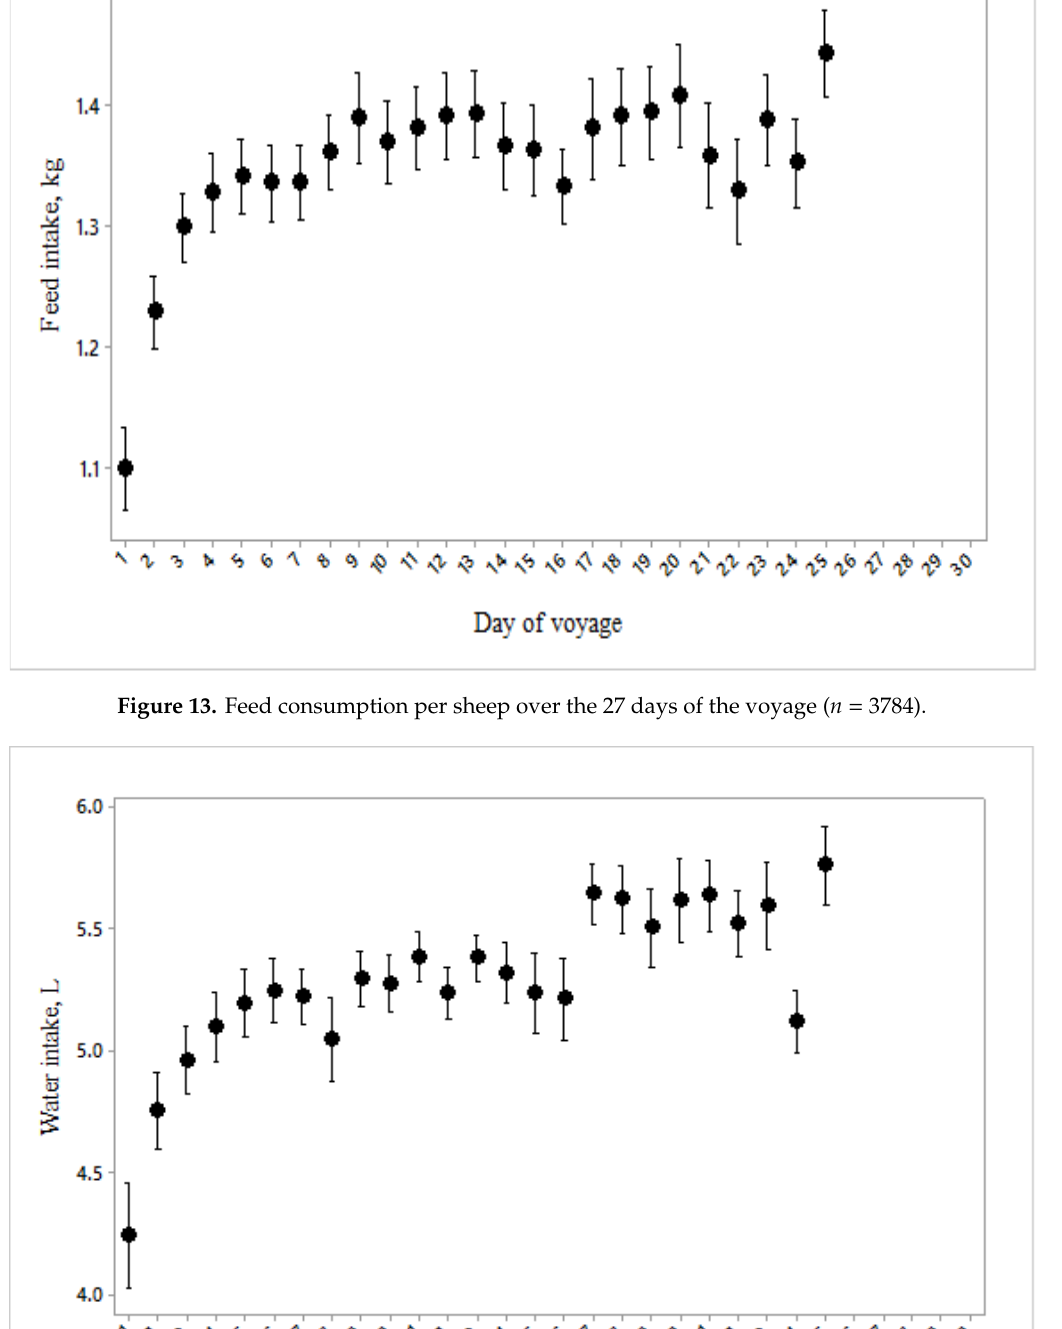
Figure 12. Relationships between water consumption, mortality and heat stress score (1 = normal, 2 = moderate and 3 = severe).